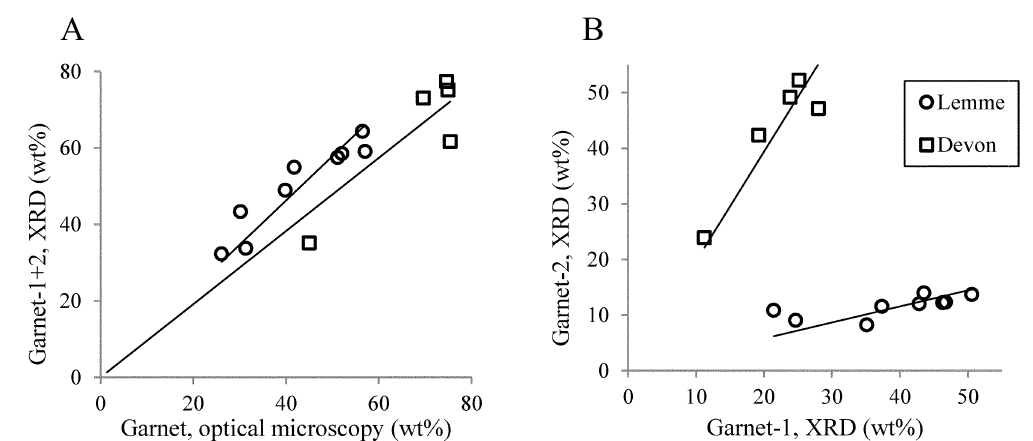
Fig. 2. Garnet mass percentage of translucent heavy minerals in the 0.05–0.1 mm fraction. A comparison of the two methods ( A ) and garnet components of different lattice parameters in the Lemme and Devonian samples ( B ).